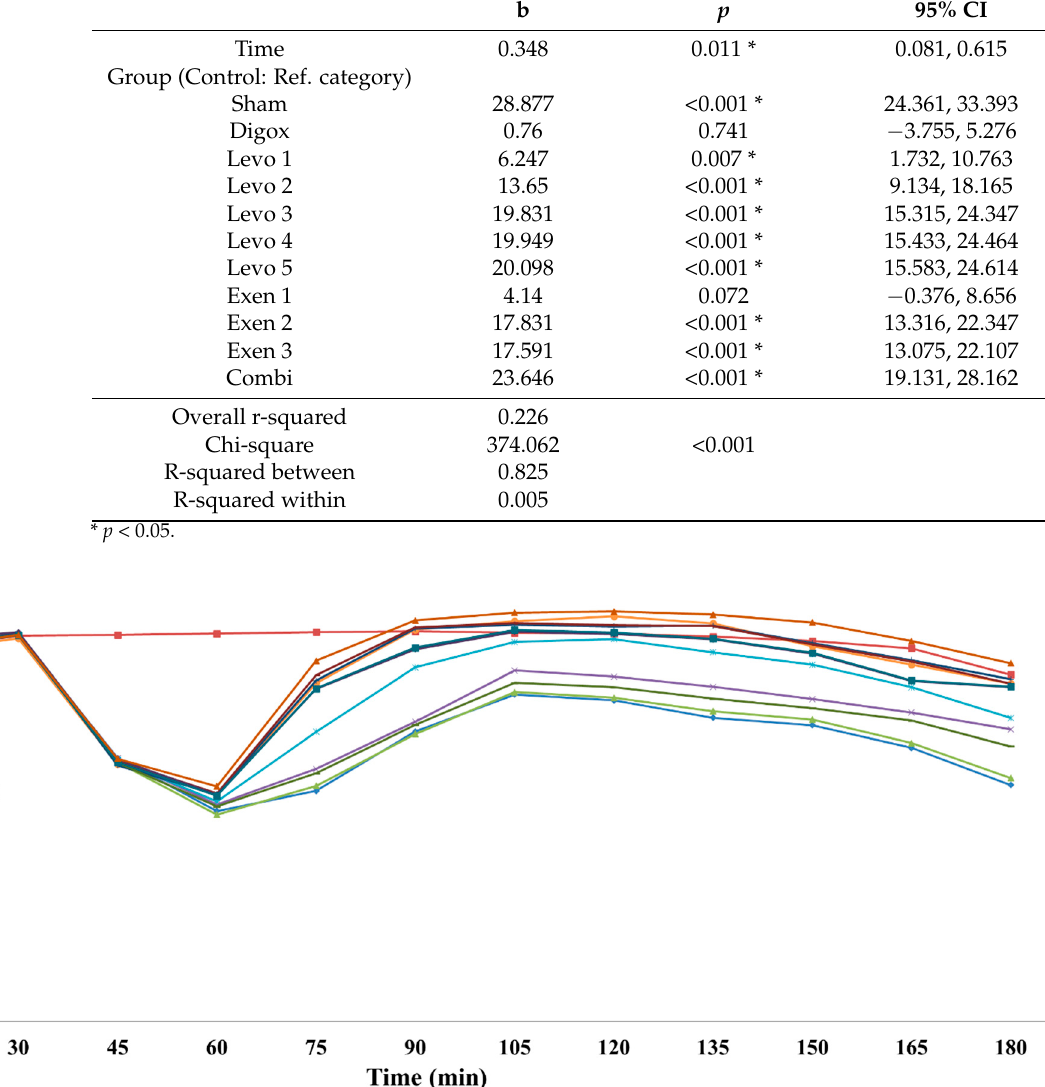
Table 3. Longitudinal analysis for LVDP for all groups.